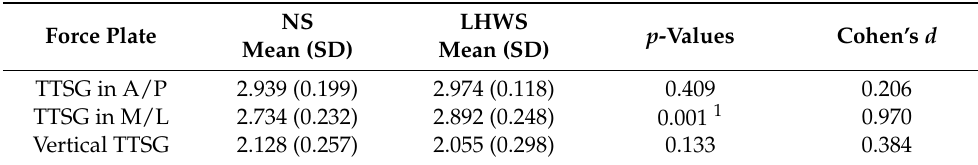
Table 1. Time to stabilization for ground reaction force(s).